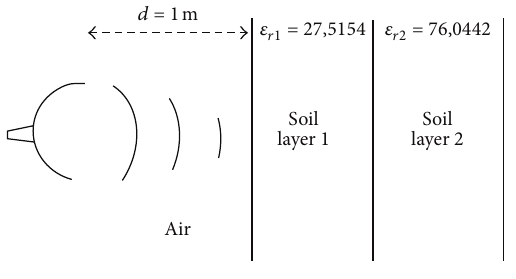
Figure 7: Radar range profile.